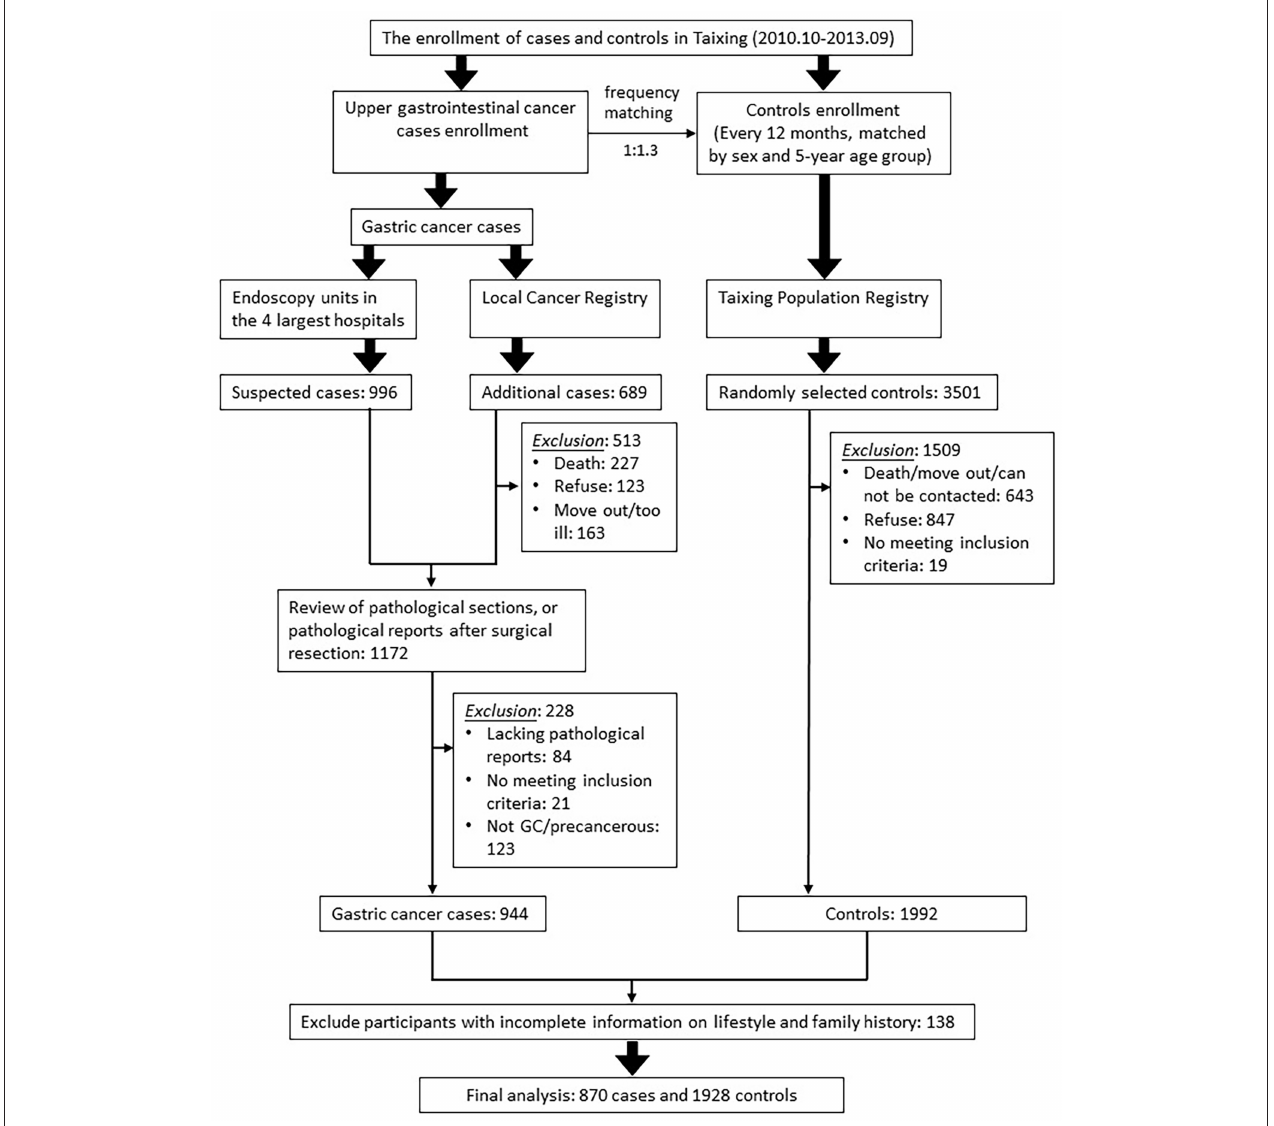
FIGURE 1 | The process of inclusion and exclusion of cases and